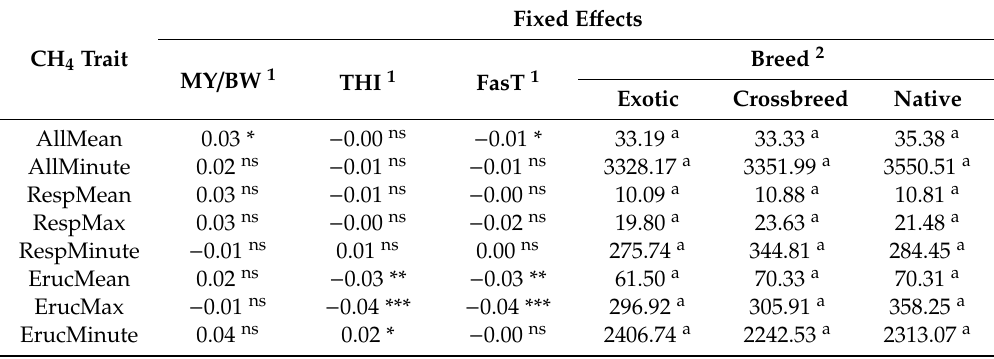
Table 4. Regression coe ffi cients of milk yield to body weight ratio (MY / BW), temperature humidity index (THI) and time interval from feeding to methane recording (FasT) and least square means of breed levels for methane emission (CH 4 ) traits.